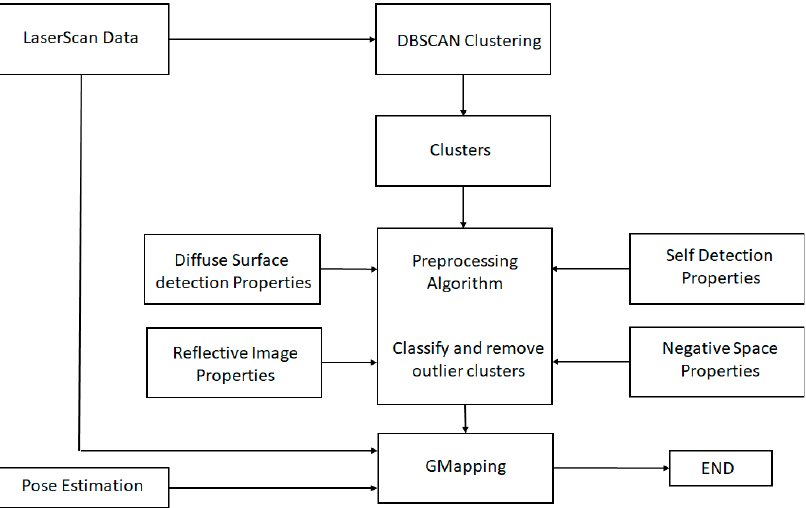
Figure 22. Proposed Preprocessing Algorithm.